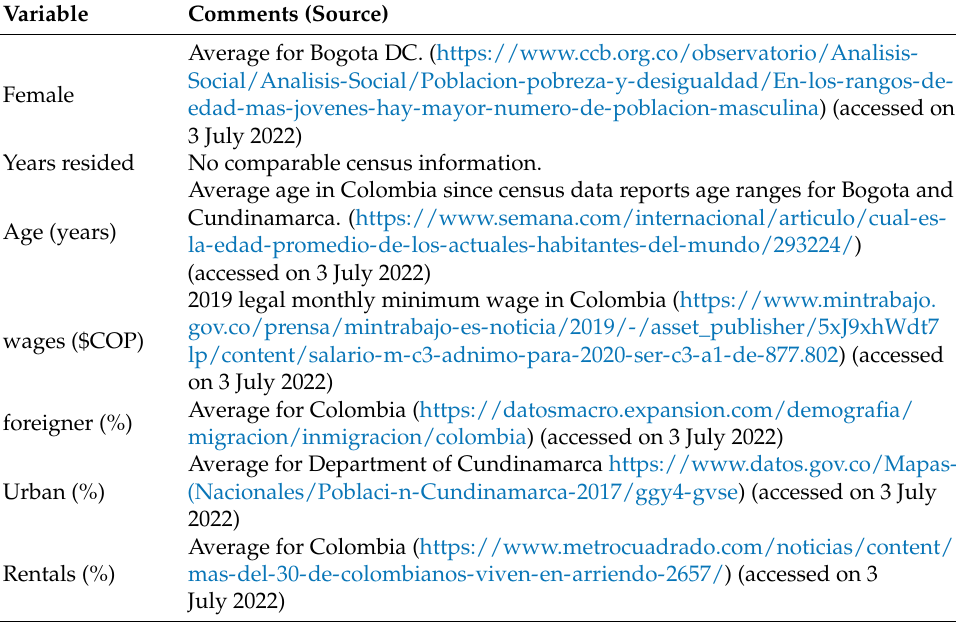
Table A1. Comments and links to data sources for sociodemographic data reported in Table 2 of the main